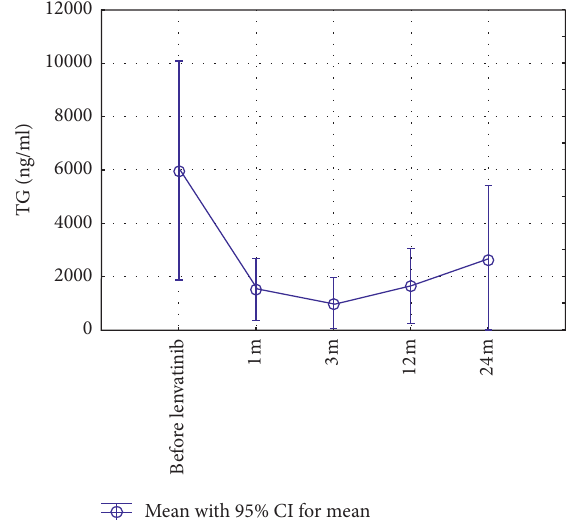
Figure 2: Change of thyroglobulin (TG) levels under therapy (1m � 1 month, 3m � 3 months, 12m � 12 months, and 24m � 24